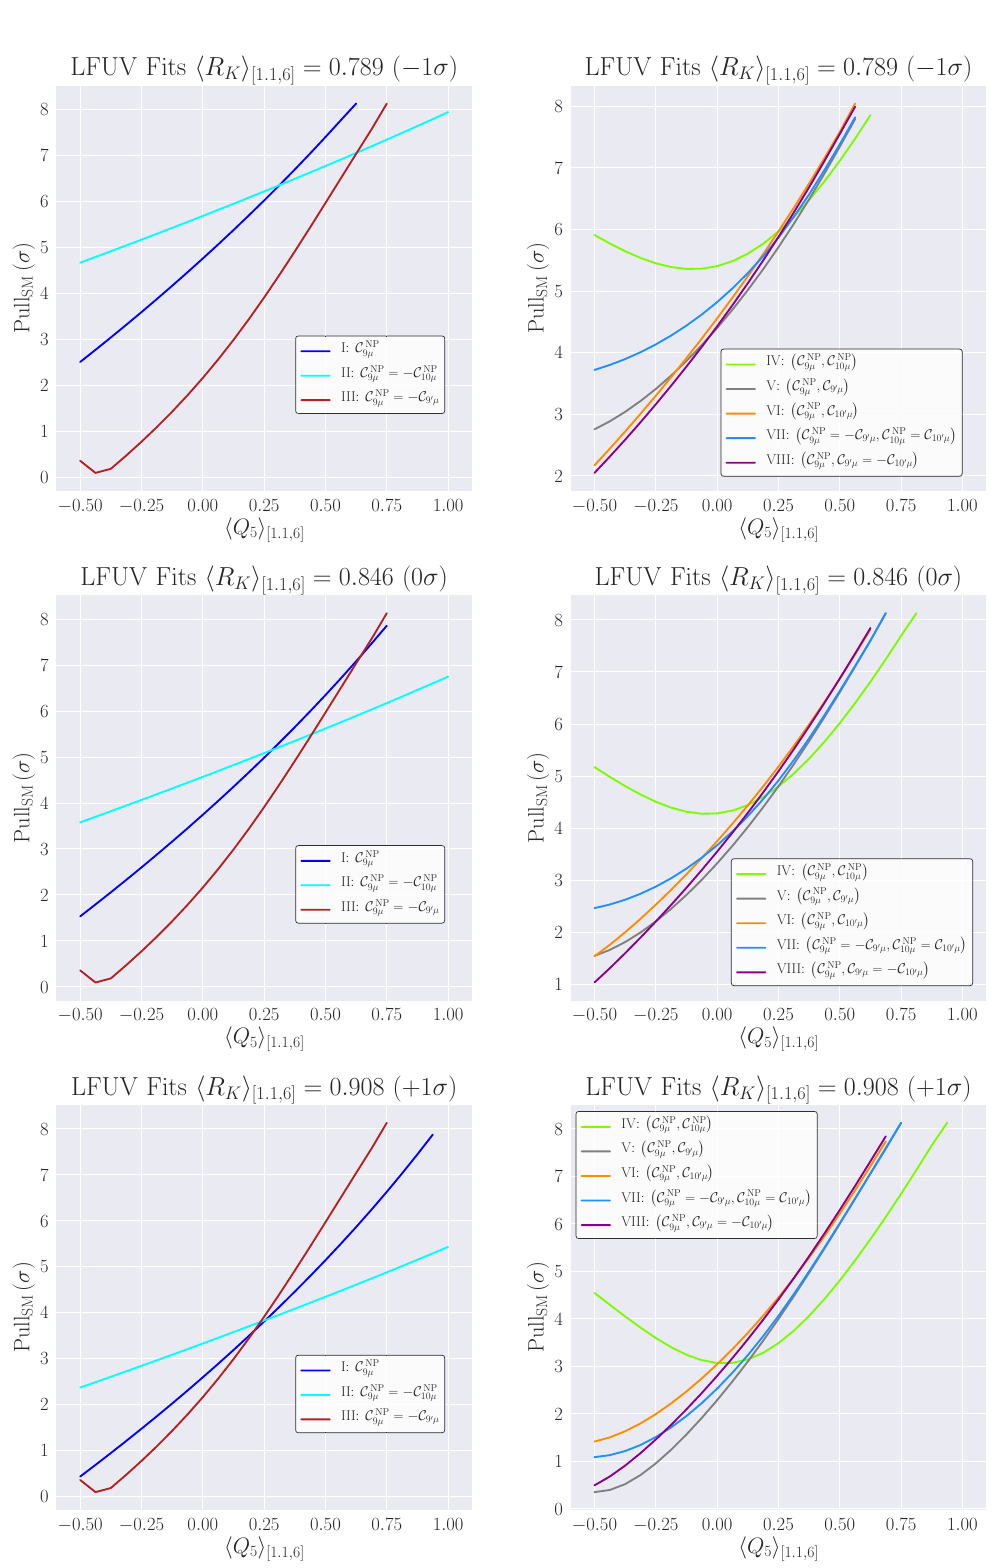
on the Pull SM of the R K (cid:31) (cid:30) [1 . 1 , 6]